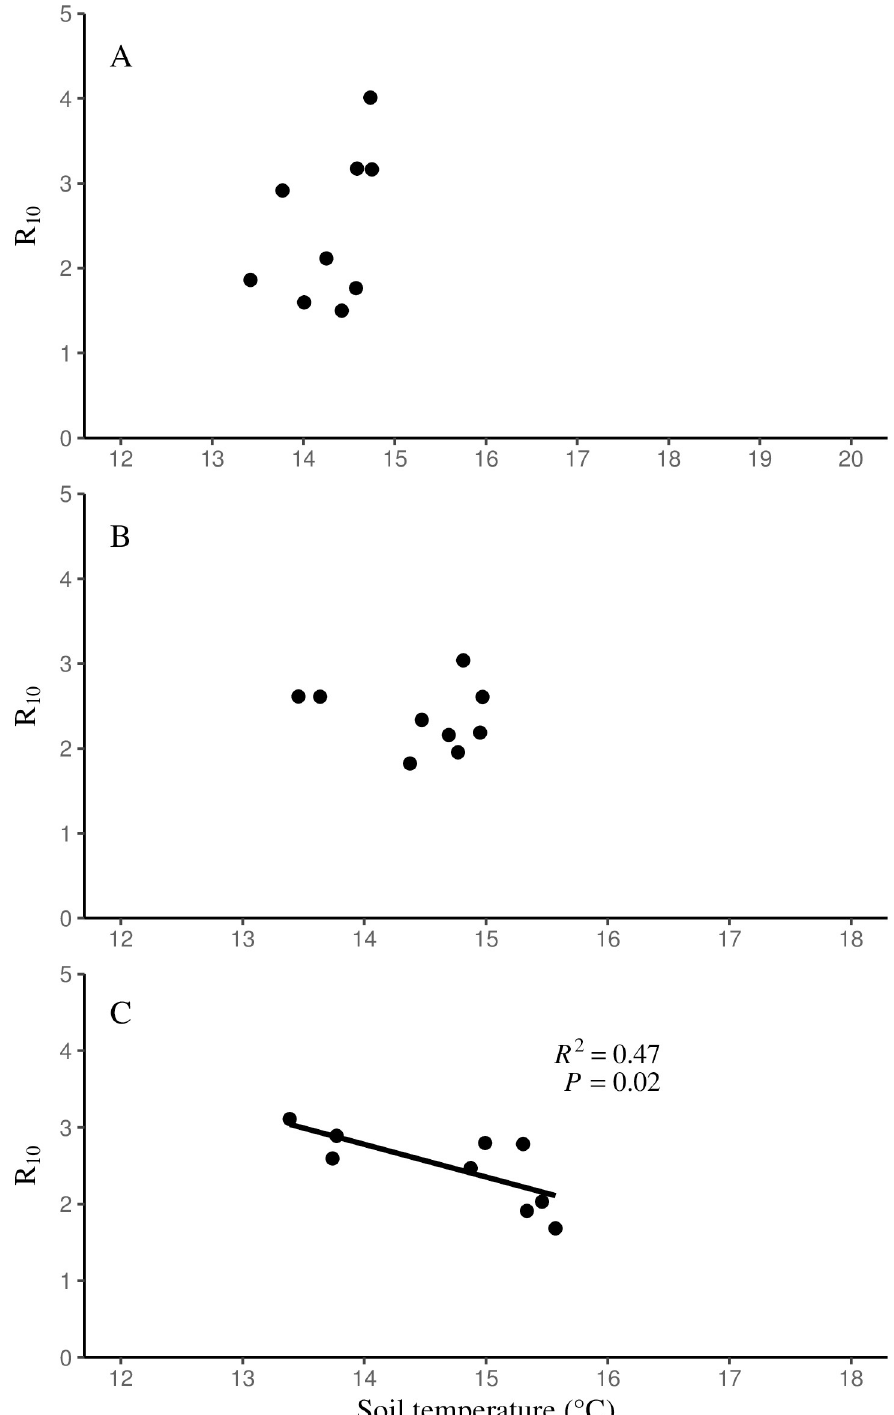
Fig 5. The relationship between R 10 and soil temperature. The relationship between R 10 and soil temperature (˚C) for hemlock (A), young birch (B), and mature birch stands (C) across all years.